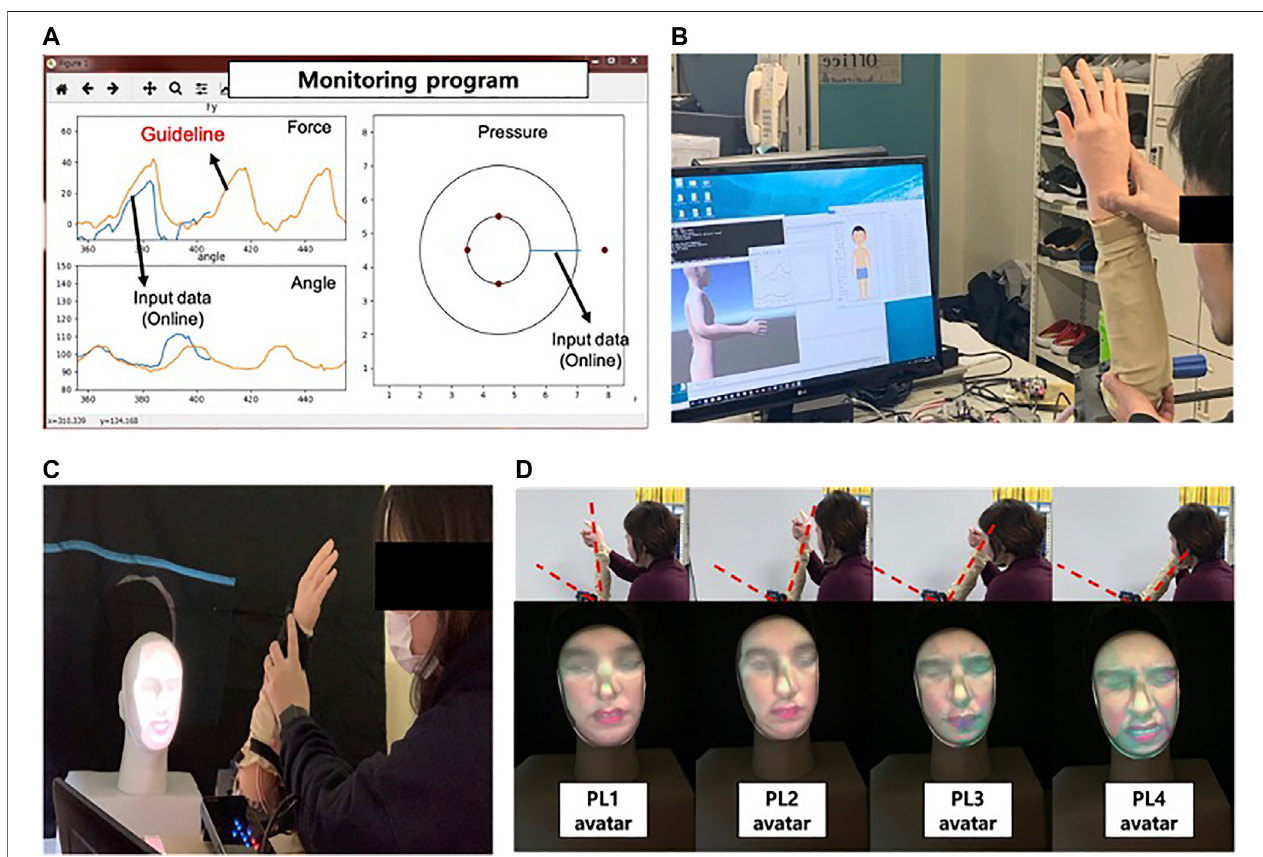
FIGURE 7 | Experimental environment: (A) monitoring program: the orange graph on the left fi gure which represents the quantitative data from expert in advance. The students can receive the training based on the expert ’ s guideline and can experience the pain to feel the elderly through the circle graph appearing on the right screen. The pressure value on the right screen represents the magnitude of the pressure from a small circle to a large circle when pressure is detected, (B) experiment using CaTARo without 3D facial expression, (C) experiment using CaTARo with 3D facial expression, and (D) sample avatar output using beam projector with 3D facial